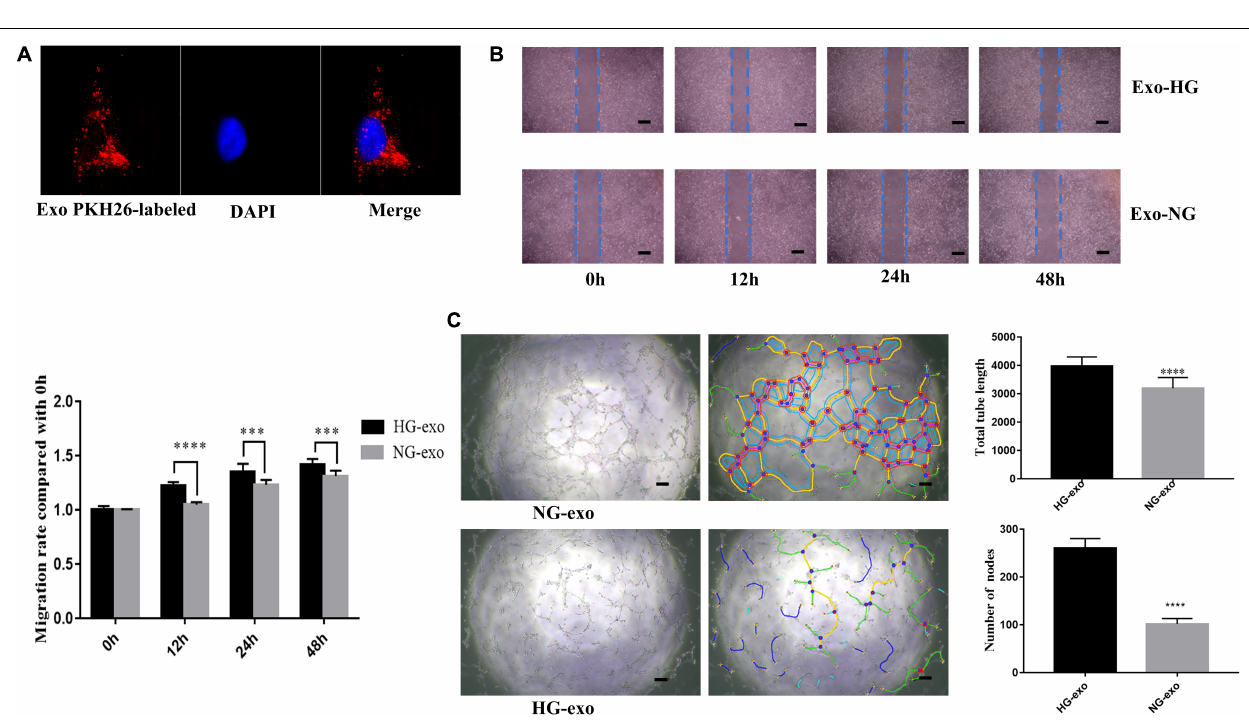
Frontiers in Genetics |